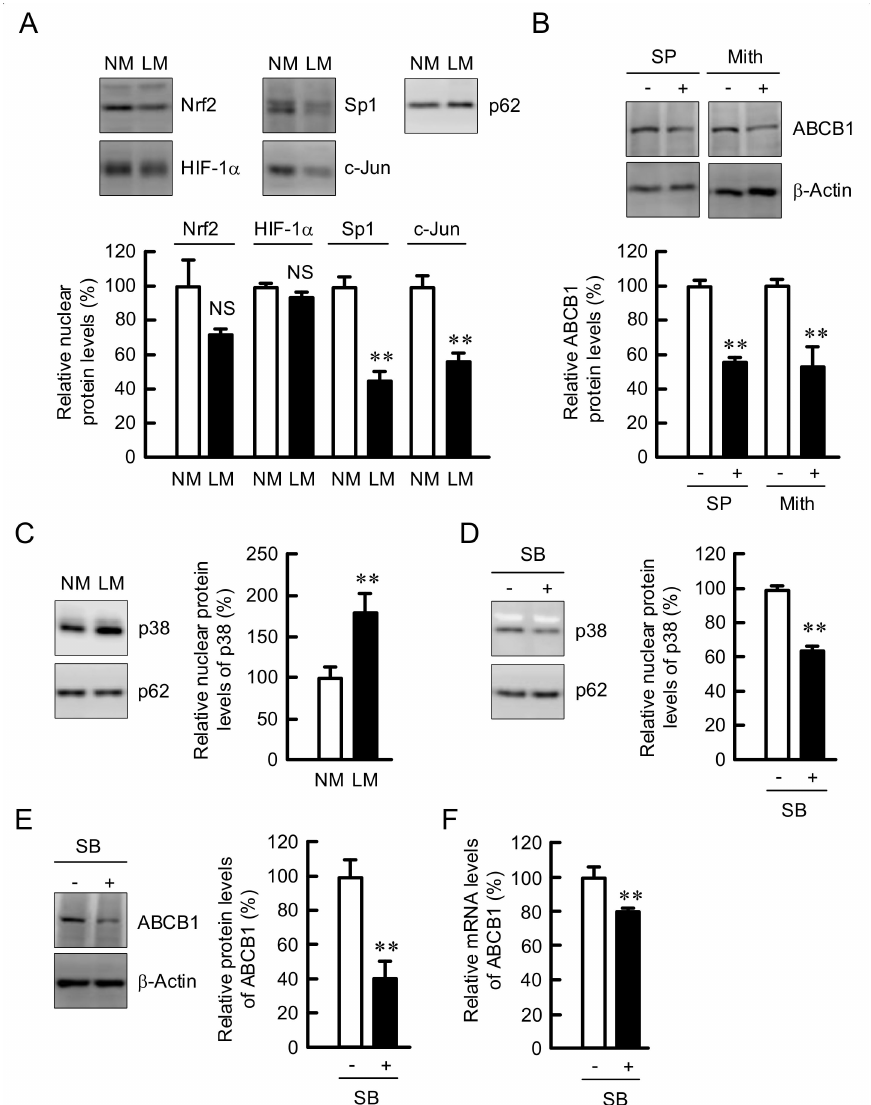
Figure 6. Decrease in the expression of ABCB1 by SB203580. ( A , C ) A549 cells were continuously cultured in the media containing NM or LM. The nuclear fraction was applied on SDS-PAGE. Western blotting was performed using anti-Nrf2, anti-HIF-1 α , anti-Sp1, anti-c-Jun, anti-p38, and anti-nucleoporin p62 (p62) antibodies. The nuclear protein levels are represented in percentage to NM. ( B ) A549 cells cultured in the NM medium were incubated in the absence and presence of 10 µ M SP600125 (SP) or 400 nM mithramycin (Mith). The protein levels are represented in percentage to the cells without SP or Mith. ( D – E ) The cells cultured in LM were incubated in the absence and presence of 10 µ M SB203580 (SB) for 3 ( D ), 24 ( E ), or 6 h ( F ). ( D ) Western blotting of the nuclear fraction was performed using anti-p38 and anti-nucleoporin p62 antibodies. ( E ) Western blotting of the cell lysates was performed using anti-ABCB1 and anti- β -actin antibodies. ( F ) Real-time PCR was performed using primer pairs for ABCB1 and β -actin. The protein and mRNA levels are represented in percentage to the cells without SB. n = 3-4. ** p < 0.01 compared with NM, -SP, -Mith, or -SB. NS, p >